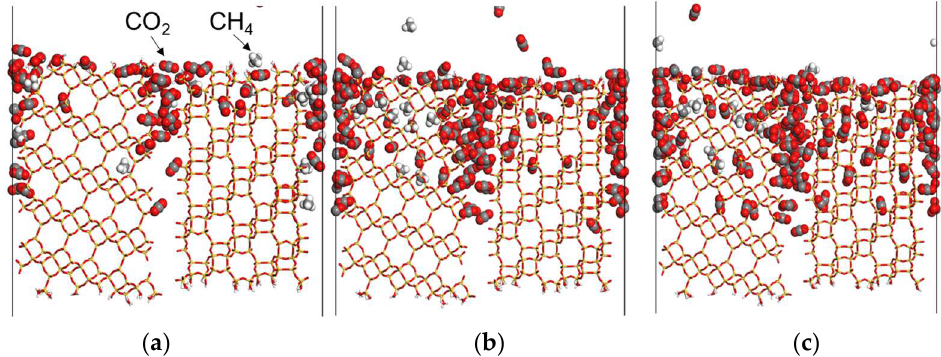
Figure 7. The snapshots of the cross view of the membrane in the unit cell were obtained from the NEMD for CO 2 /CH 4 mixture gas permeation at high pressure. CO 2 and CH 4 molecules by the CPK model represented the carbon atoms in gray, oxygen atoms in red, and hydrogen atoms in white, whereas the CHA zeolite was represented by the stick model. ( a ) 5 ns, ( b ) 10 ns, and ( c ) 15 ns.